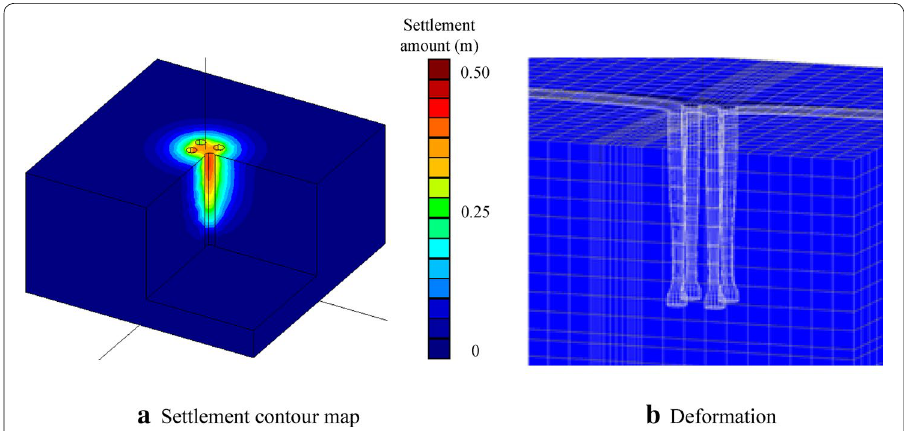
Fig. 5 Deformation behavior of surrounding ground when four pullout holes are hollow. a Settlement contour map. b